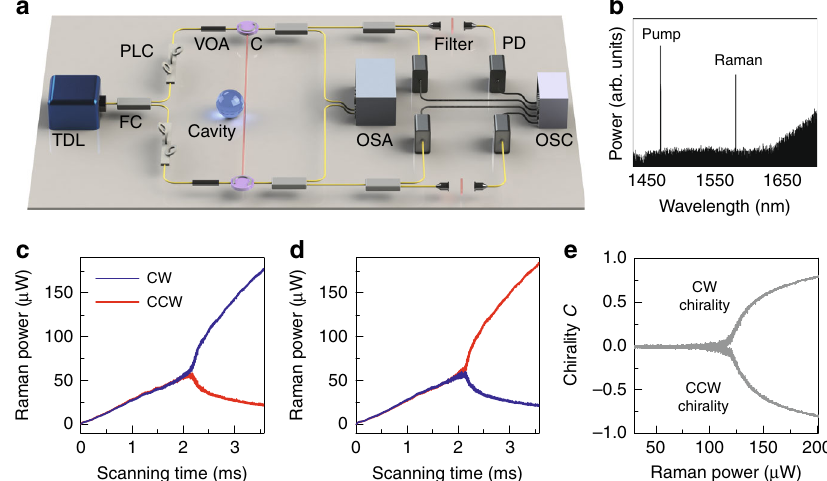
Fig. 2 Experimental set-up and observation of a symmetry-broken Raman microlaser. a Illustration of experimental set-up. TDL tunable diode laser, OSA optical spectrum analyzer, PLC polarization controller, C optical circulator, PD photodetector, VOA variable optical attenuator, FC fi ber coupler, OSC oscilloscope. b Optical spectra of the pump light and Raman laser. c , d CW (CCW) Raman output power P cw ( P ccw ) vs. frequency-sweeping time. As the scanning time increases, the intracavity pump power becomes stronger, leading to chiral emission with CW ( c ) or CCW directionality ( d ). e Dependence of the chirality C on the total Raman power, exhibiting a balanced pitchfork